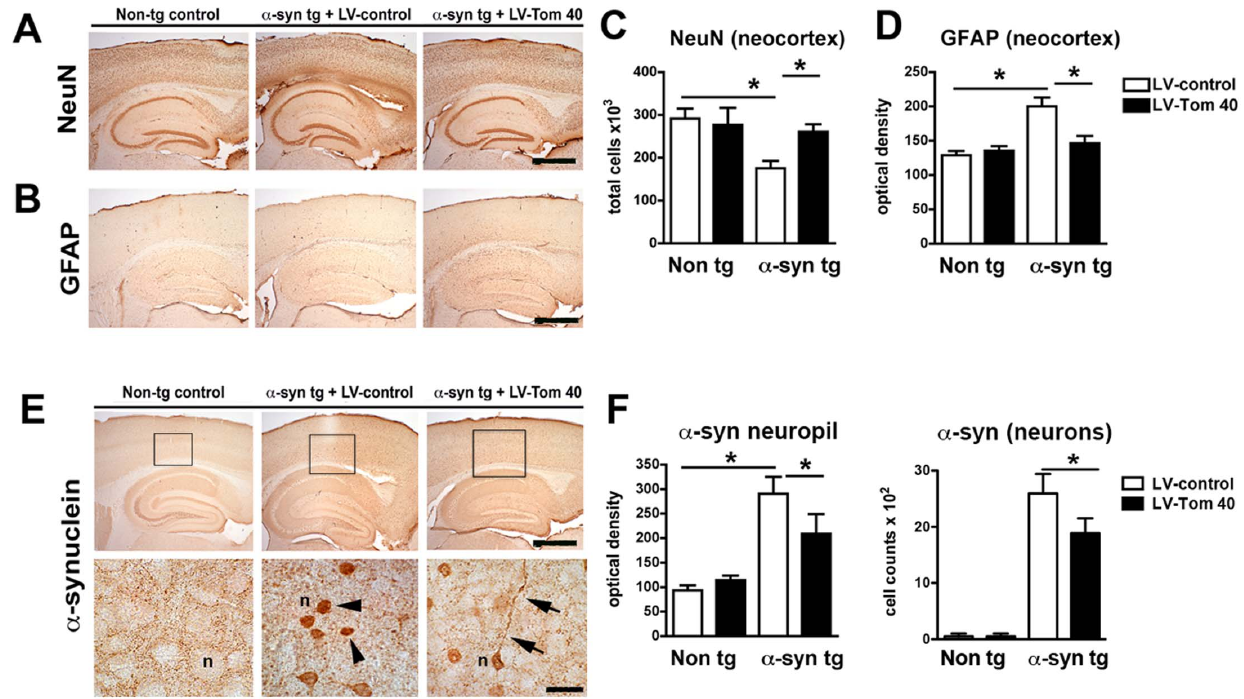
Figure 6. Tom40 overexpression reduces accumulation of a -Syn in neuronal cells. (A and B) Immunostaining of neuronal (anti-Neu N, upper panel) and glial (anti-GFAP, lower panel) cells in non-transgenic control animals and a -Syn tg mice that received LV-control or LV-Tom40 gene therapy. Scale bar represents 250 m m. (C and D) Stereological analysis of anti-NeuN and anti-GFAP-labeling, respectively (number of positive cells). (E) Effect of Tom40 overexpression on a -Syn levels: immunostaining of a -Syn on sagittal brain sections from non-transgenic (non-tg) controls, a -Syn-tg mice that received control lentivirus and a -Syn-tg mice injected with Tom40-lentivirus. Scale bar represents 250 m m in the upper panel and 50 m m in the lower panel. (F) Stereological analysis of a -Syn immunosignal (number of positive cells) showing reduced a -Syn levels on Tom40-overexpressing animals. *p , 0.05 per Student’s t test.